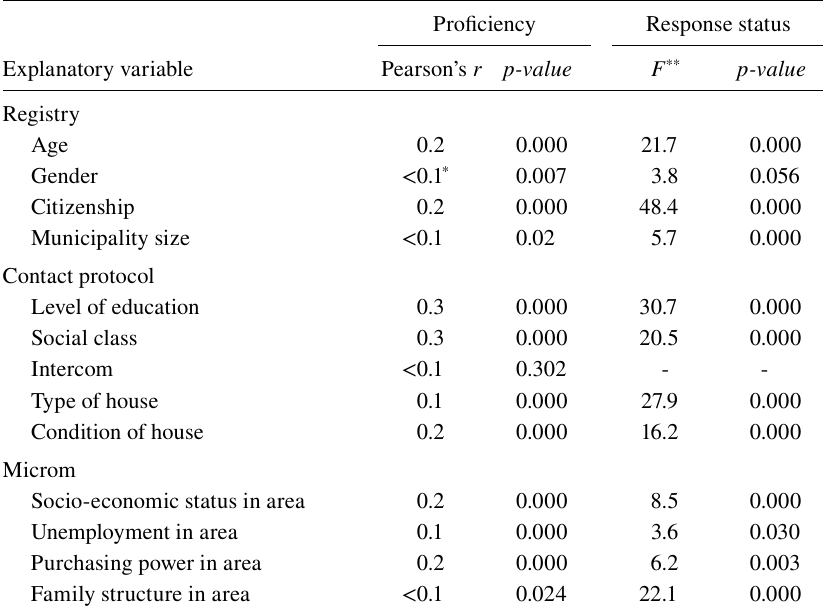
Associations of explanatory variables with proficiency and